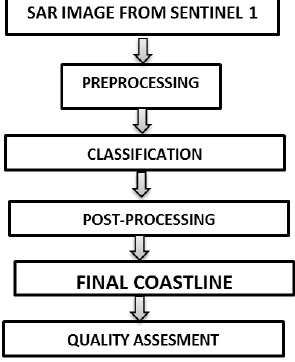
Figure 3. Processing